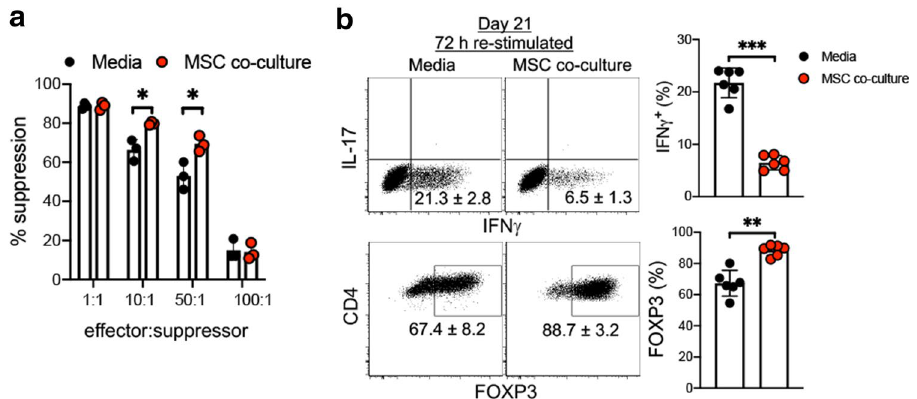
Figure 2. MSC co-culture stabilises FOXP3 expression in iTregs in the presence of inflammatory cytokines. ( a ) Suppressive effects of iTregs were measured day 21 of ex vivo expansion of iTregs in IL-2/media vs MSC co-culture, CD25 high FACS sorted iTregs were used to test suppressive function. 4 days after stimulation, CFSE dilution was examined by FACS ( n = 3). ( b ) Expression of FOXP3 on iTregs was measured following 72 h restimulation with CD3 and CD28 antibodies (1 μg ml −1 ) in the presence of inflammatory cytokines IFNγ (10 μg ml −1 ), IL-6 (10 μg ml −1 ), and TNF (10 μg ml −1 ) at concentration of 5 × 10 5 cells ml −1 and analyzed by FACS. Intracellular IFNγ and IL-17 were detected by flow cytometry analysis. Data are representative of two independent experiments ± SD ( n = 6–7) ** p < 0.01, *** p < 0.001 paired t test. See also Supplementary Fig. S2.